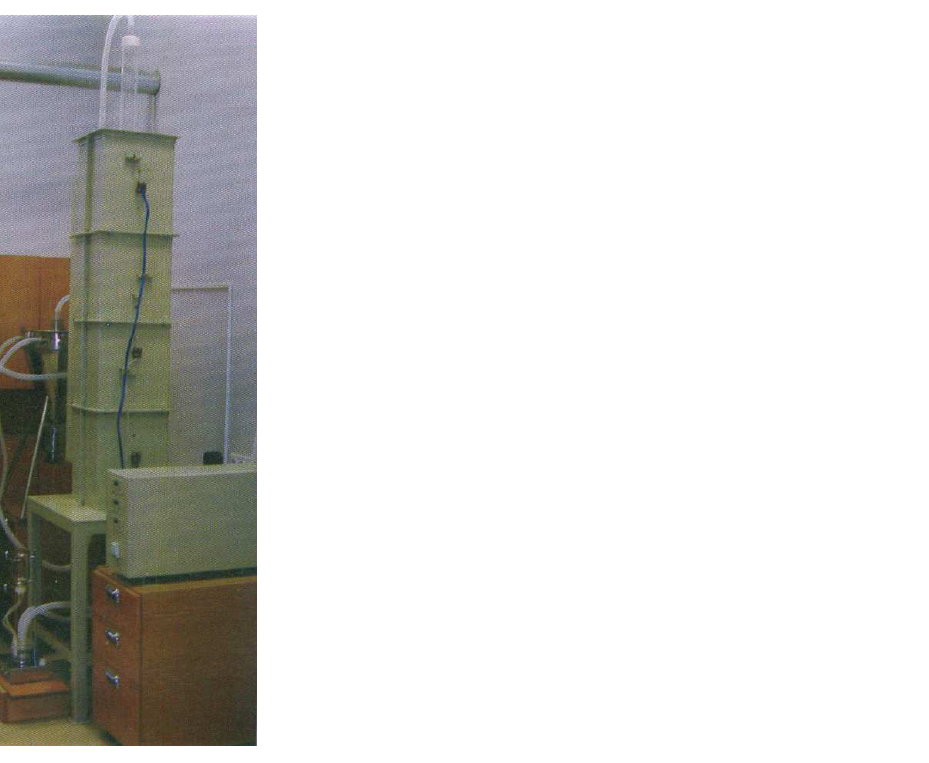
Figure 2. General view of a laboratory equipment for the synthesis of aerosol powders by ultrasonic spray pyrolysis.